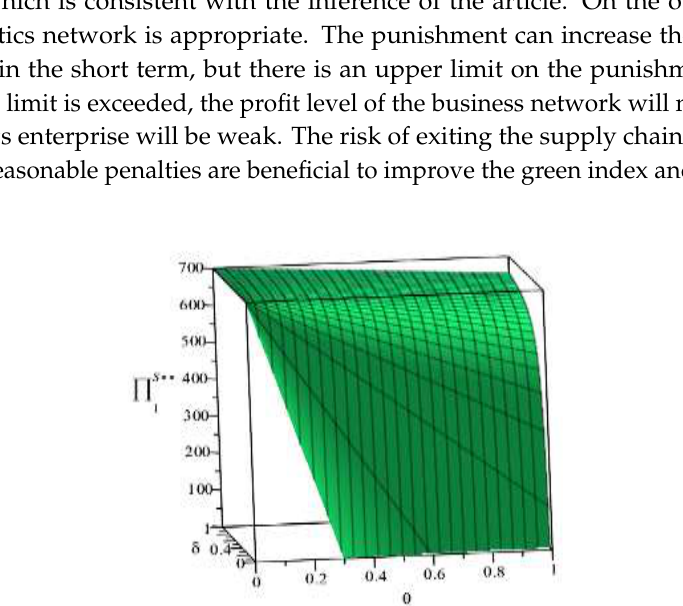
Figure 7. Effect of manufacturer's behavior 𝜃 , 𝛿 on business flow network under speculative conditions.